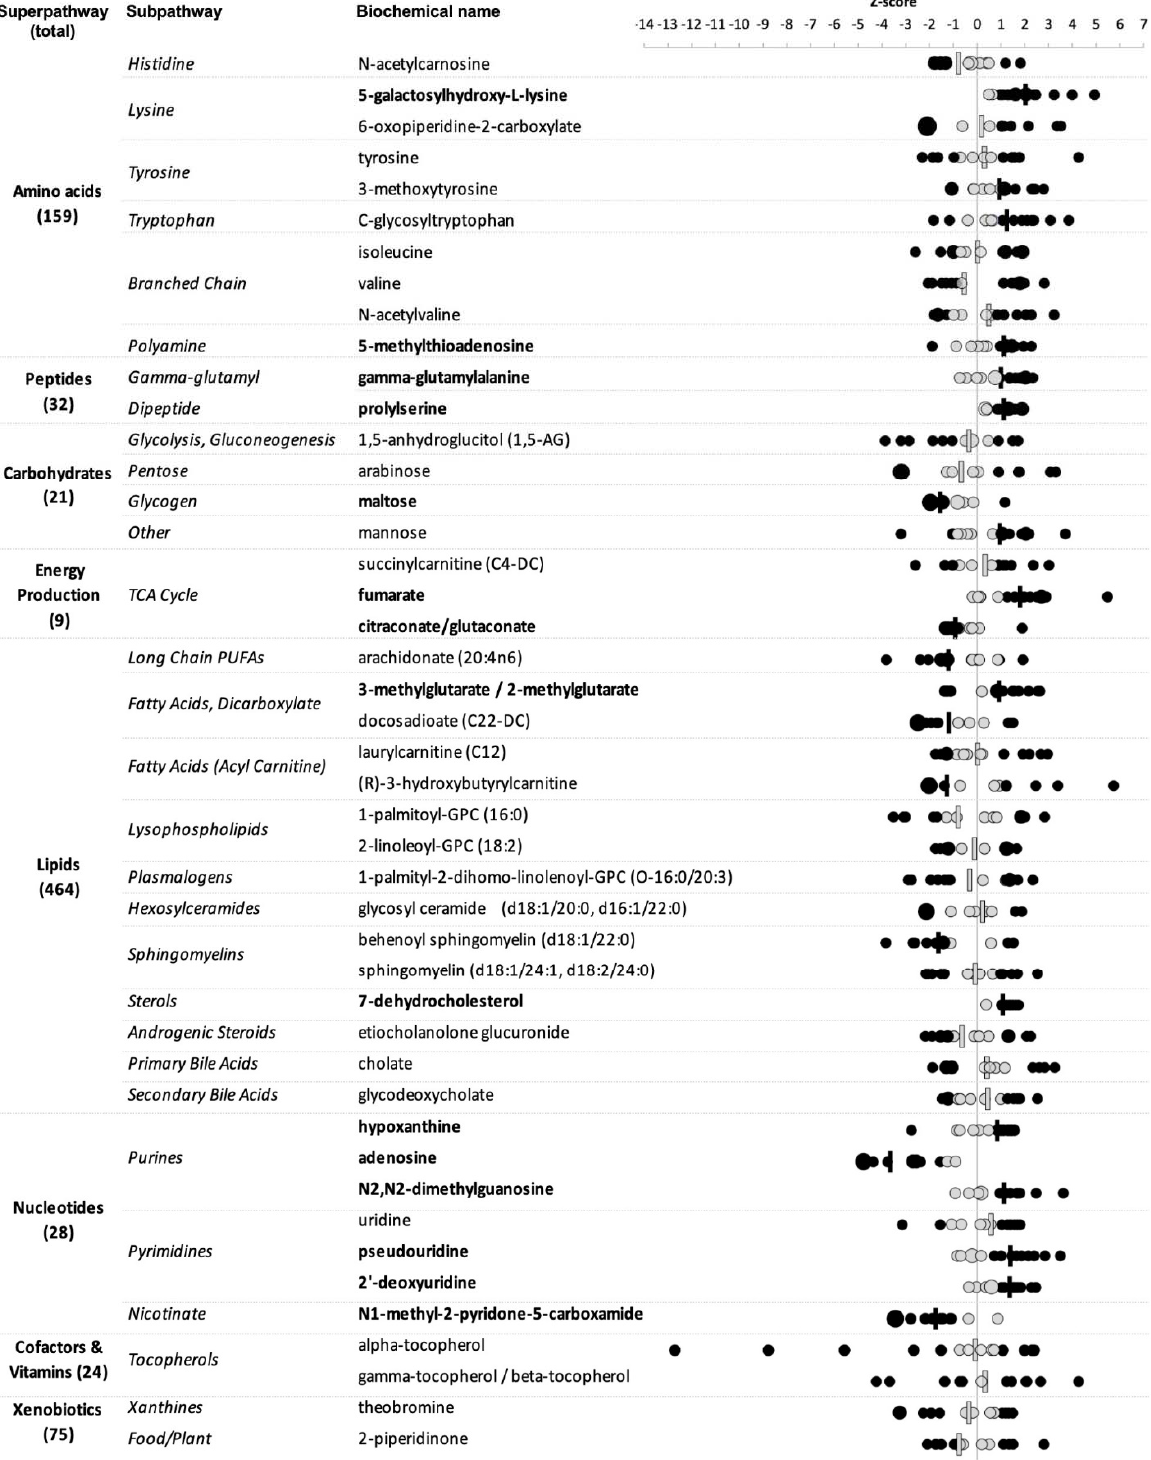
Figure 2 Altered metabolites in GBCA-exposed patients with persistent symptoms.